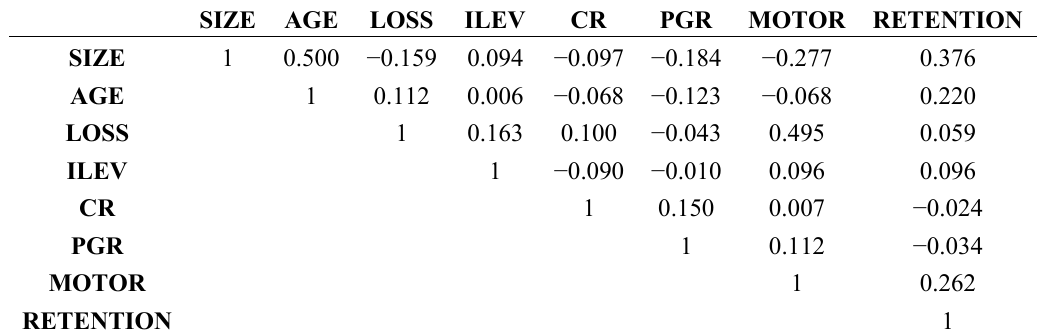
Table 2. Correlation Coefficients between Independent